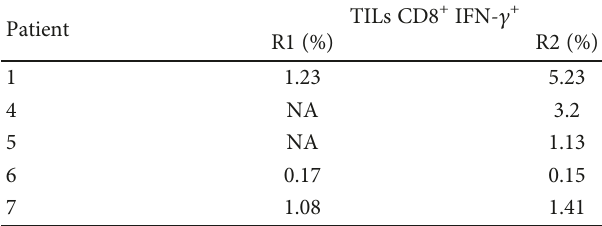
Table 6: Proportion of speci fi c tumor-TILs.